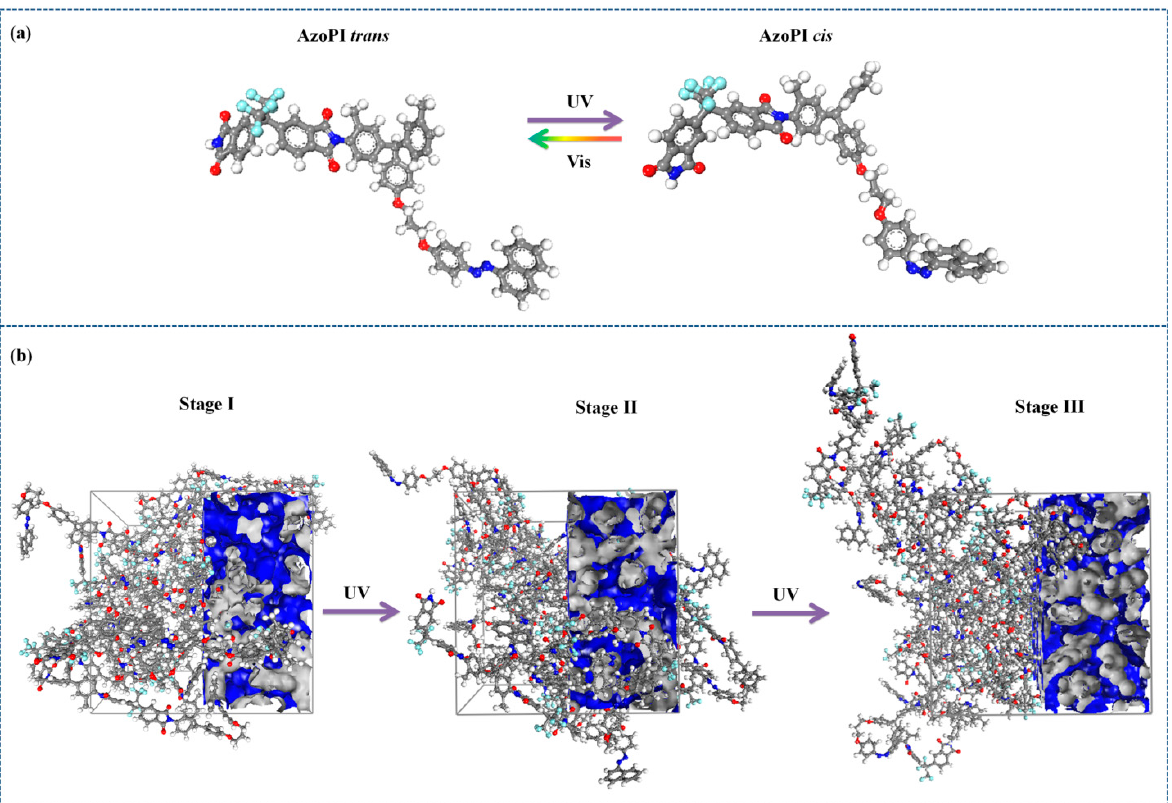
Figure 9. Molecular modeling of the photo-isomerization process of the azo-naphthalene groups: ( a ) minimum energy conformations of a AzoPI repeating unit in trans and cis states; ( b ) three-dimensional view of one amorphous cell for the AzoPI in stage I, stage II, and stage III (three polymer chains inside, each containing 10 repeating units; the grey surface indicates the Van der Waals surface, the blue surface indicates the void surface).